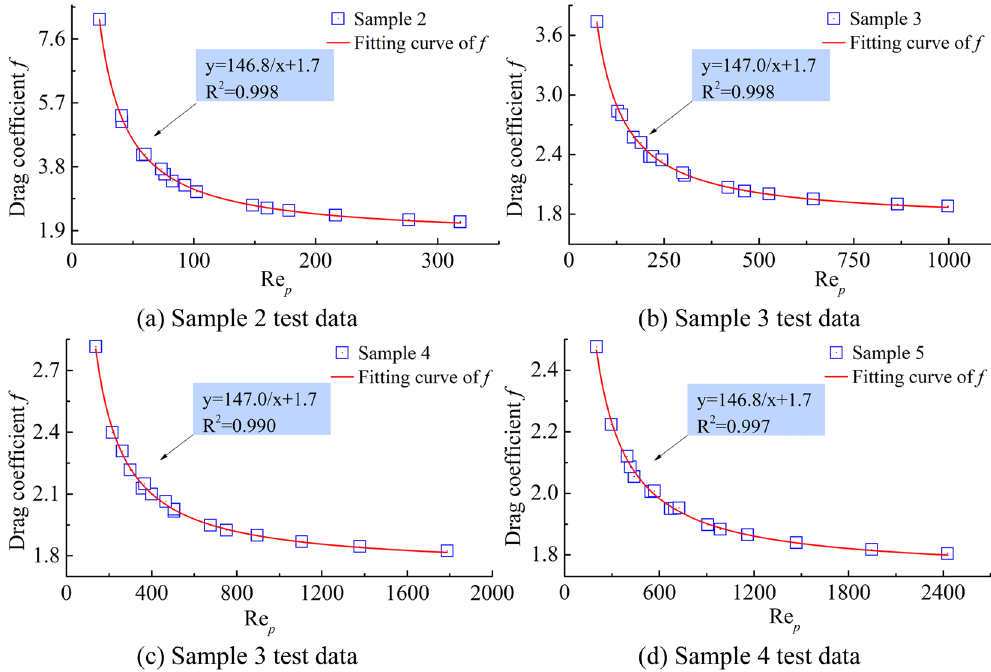
Figure 4. Effect of Reynolds number on drag